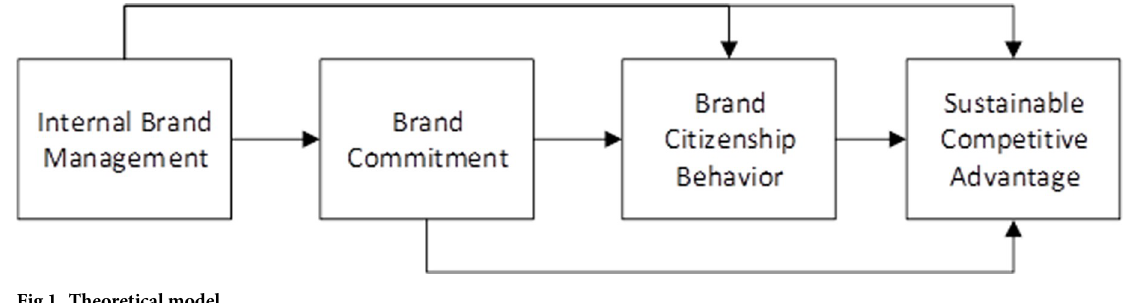
Fig 1. Theoretical